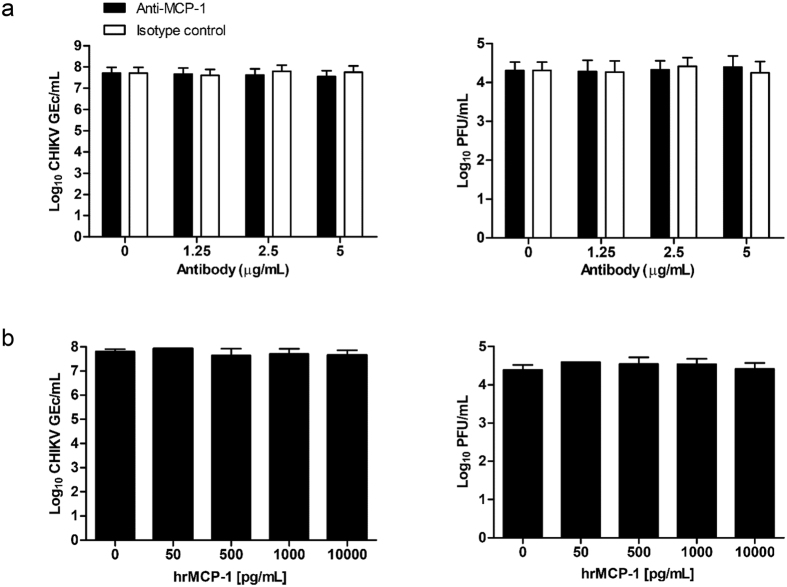
Modulation of MCP-1 levels in the course of infection had no effect on CHIKV production.(a) Neutralization of MCP-1 before and during CHIKV infection of PBMCs had no effect on virus replication. Bars represent mean + s.e.m., n = 2. (b) CHIKV infection in the presence of increasing concentrations of human recombinant MCP-1 (hrMCP-1) had no effect on virus replication. Bars represent mean + s.e.m., n = 2.